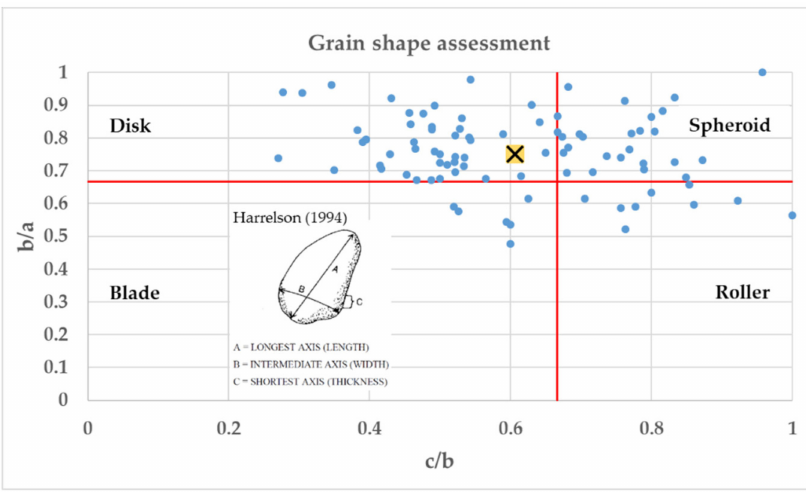
Figure 6. Grain shape assessment results (with blue dots) and the calculated average shape (marked with black X) on a Zingg diagram. The meaning of the axes is also shown.